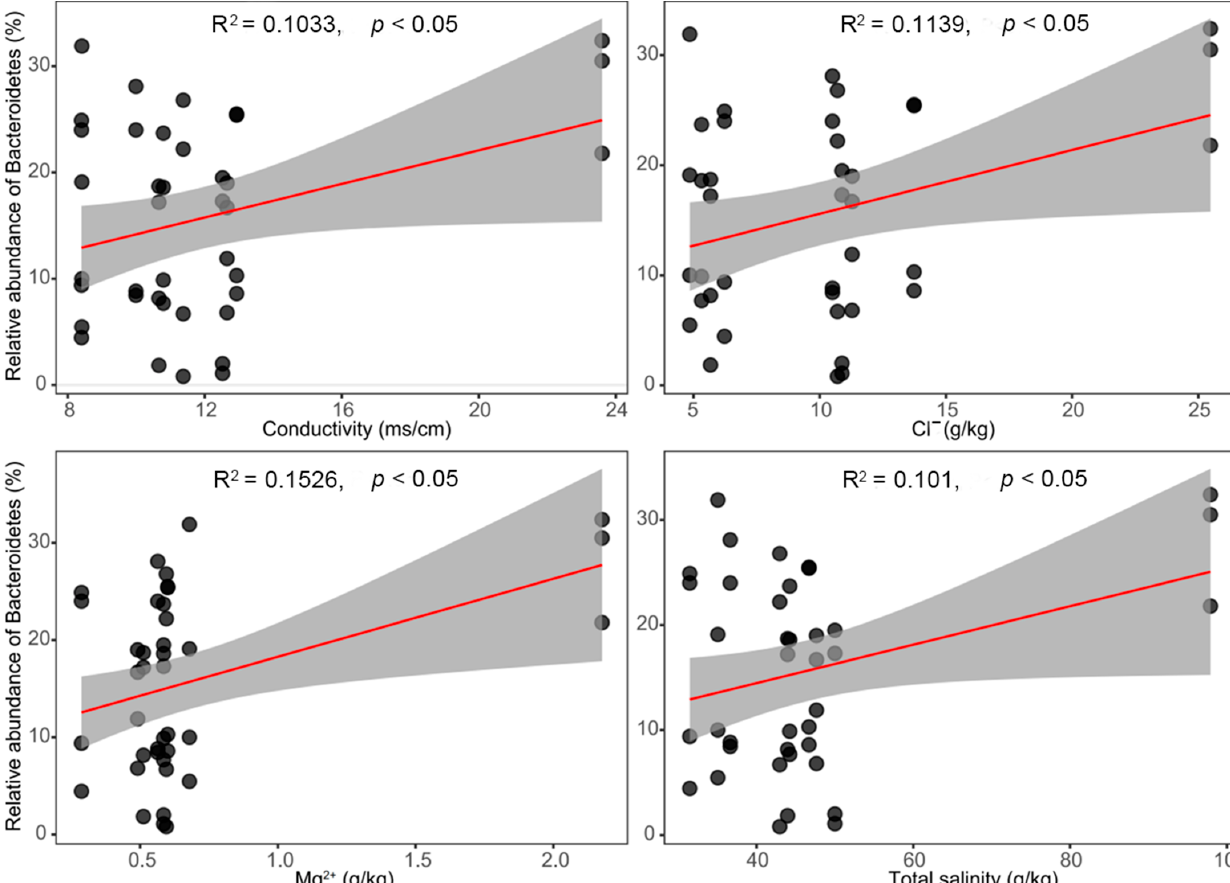
Figure 7. Correlation analysis between environmental factors and relative abundance of the dominant phylum Bacteroidetes (shading indicates the 95% confidence).